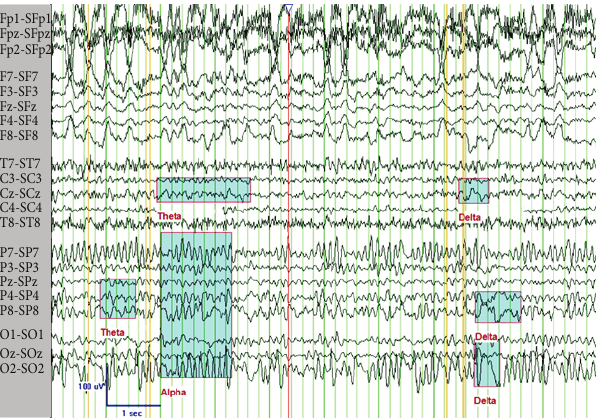
Figure 1: Awake EEG using transverse Laplacian montage, showing normal 9 Hz alpha rhythm in the posterior head regions, as well as abnormal 5-6Hz theta and 2–4 Hz delta slowing seen diffusely but most prominent in the right posterior temporal (P8), parietal (P4), and occipital (O2) head